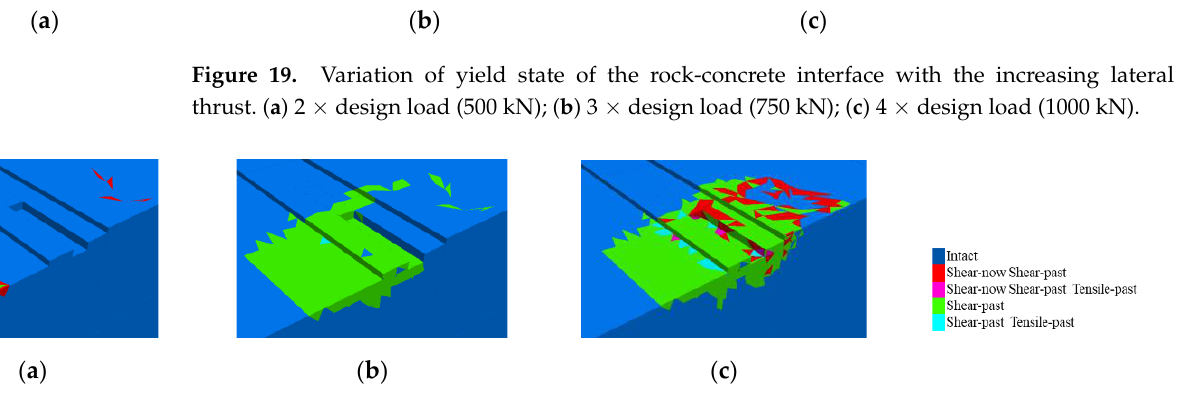
Figure 20. Variation of yield state of the foundation rock mass with the increasing lateral thrust. ( a )